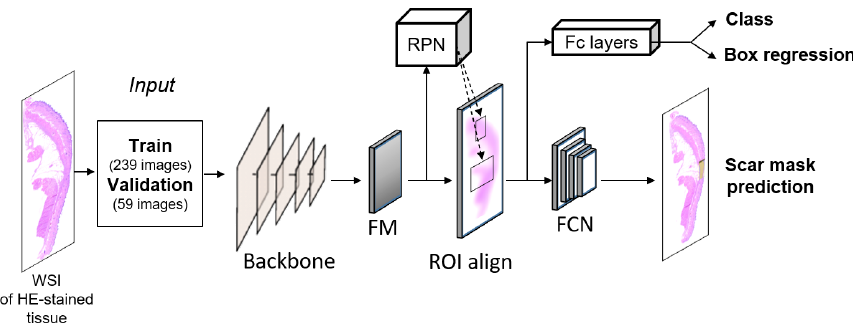
Figure 3. Block diagram of Mask region-based convolutional neural network (RCNN) algorithm for scar identification from histology slides (FM = Feature maps, RPN = region proposal network; FCN = fully connected network; FC layer = fully connected